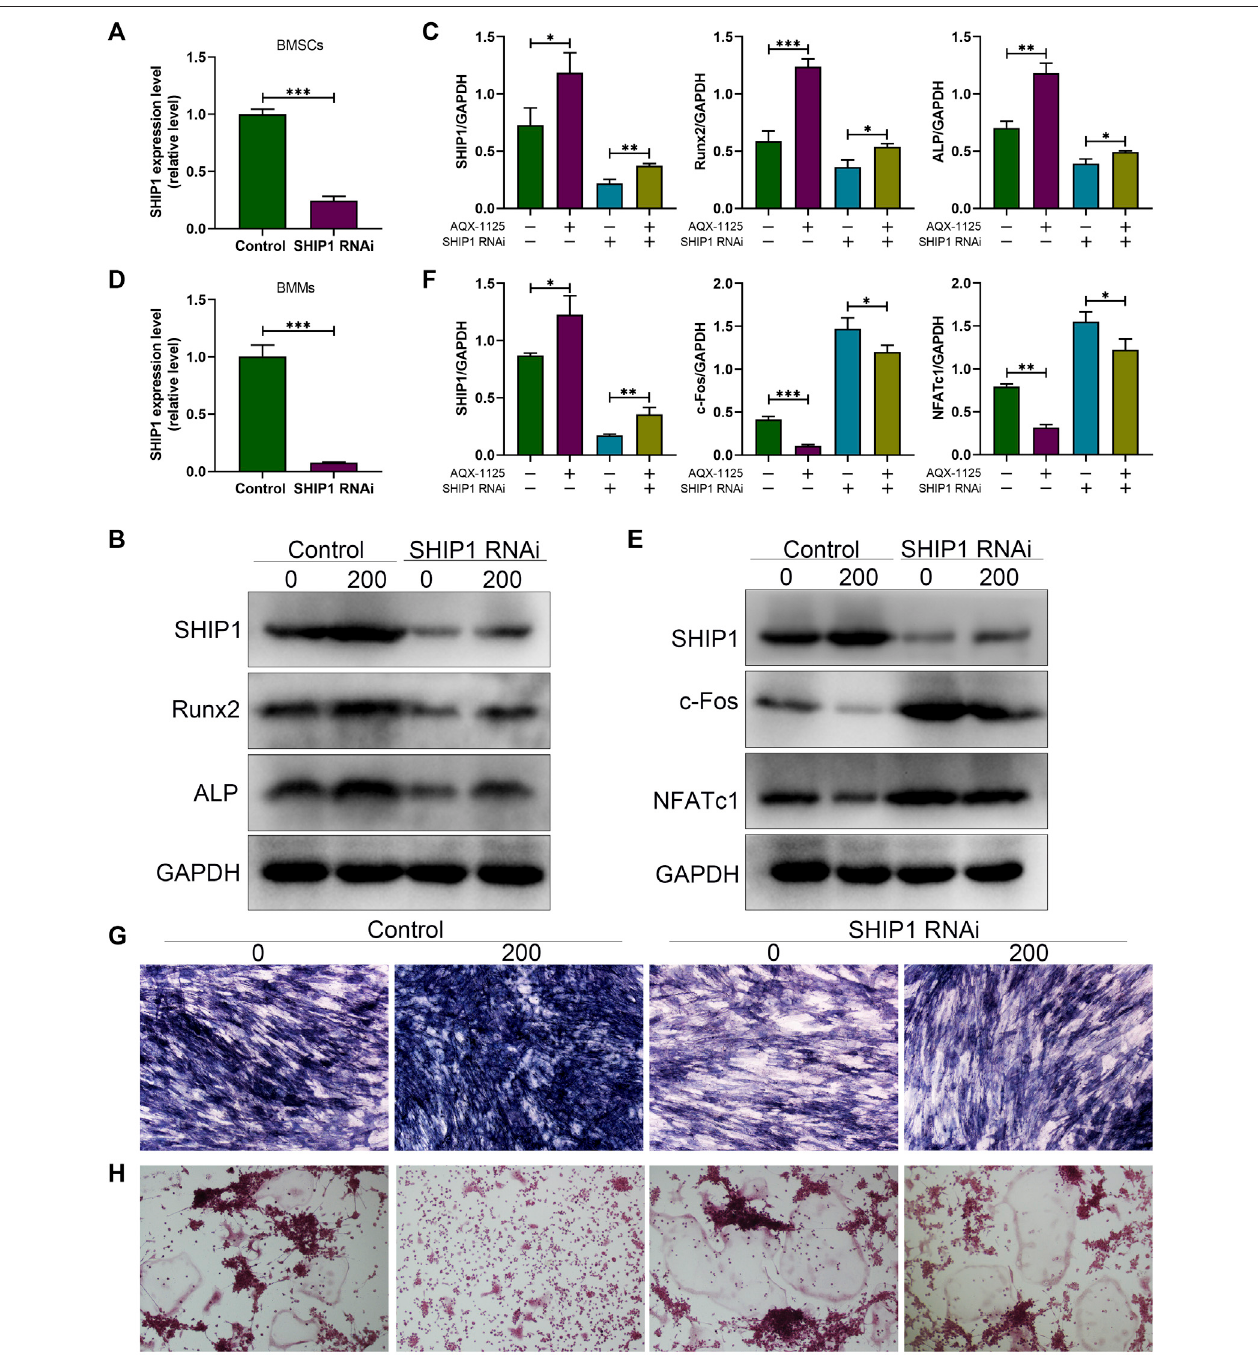
FIGURE 6 | Increased osteogenesis and decreased osteoclastogenesis induced by AQX-1125 are SHIP1-dependent. (A) Gene expression level of SHIP1 in BMSCsaftertransfectionwithSHIP1RNAi. (B) ProteinexpressionlevelsofSHIP1,Runx2,andAlpinBMSCswithorwithoutAQX-1125,weredetected4 daysfollowing transfection with SHIP1 RNAi. (C) Quantitative analysis of each immunoblot in (B) . (D) Gene expression level of SHIP1 in BMMs after transfection with SHIP1 RNAi. (E) BMMs were treated with or without AQX-1125 for 3 days in the presence of M-CSF and RANKL. The expression levels of SHIP1, NFATc1, and c-Fos was measured with Western blotting. (F) Quantitative analysis of each immunoblot in (E) . (G) BMSCs were transfected with SHIP1 RNAi for 48 h, and then, Alp staining was performed14 daysafterosteogenicinductionintheabsenceorpresenceofAQX-1125.Scalebars=100 μ m. (H) BMMswereincubatedwithSHIP1RNAifor48 h,and then TRAP staining was used to test the effect of SHIP1 RNAi on AQX-1125-mediated osteoclastogenesis after 5-days incubation with differentiation medium in the absence or presence of AQX-1125. TRAP staining was used to test the effect of SHIP1 RNAi on AQX-1125-mediated osteoclastogenesis. Scale bars = 100 μ m. Data are presented as means ± SD from three independent experiments (* p < 0.05; ** p < 0.01; and *** p < 0.001).